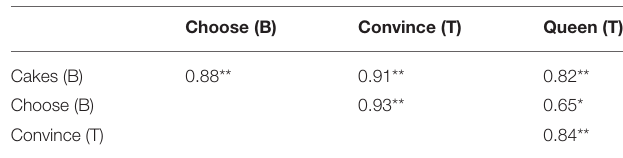
TABLE 2 | Correlations of Mean IOI between each pair of sentences in Experiment